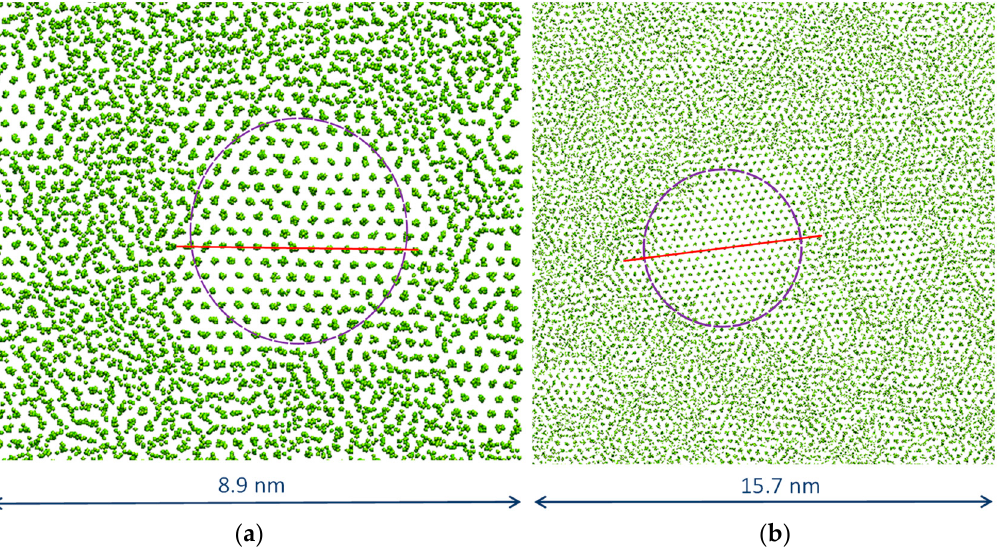
Figure 7. Time-averaged atomic positions in L3 of the simulation systems with ( a ) 8% lattice misfit; and ( b ) −8 % lattice misfit showing the atomic arrangement in the 2D nuclei relative to that in the substrate. There is no lattice twist in the system with 8% lattice misfit, while there is a 6° twist in the system with −8 % lattice misfit. The red lines mark the <110> direction of the 2D nuclei, and the <110> direction of the substrate is parallel to the bottom edge of the images.